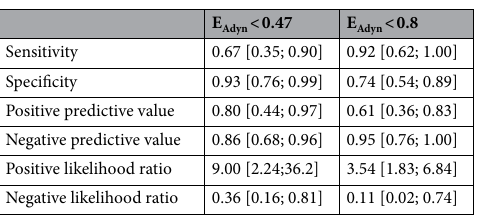
E Adyn < 0.47 E Adyn < 0.8